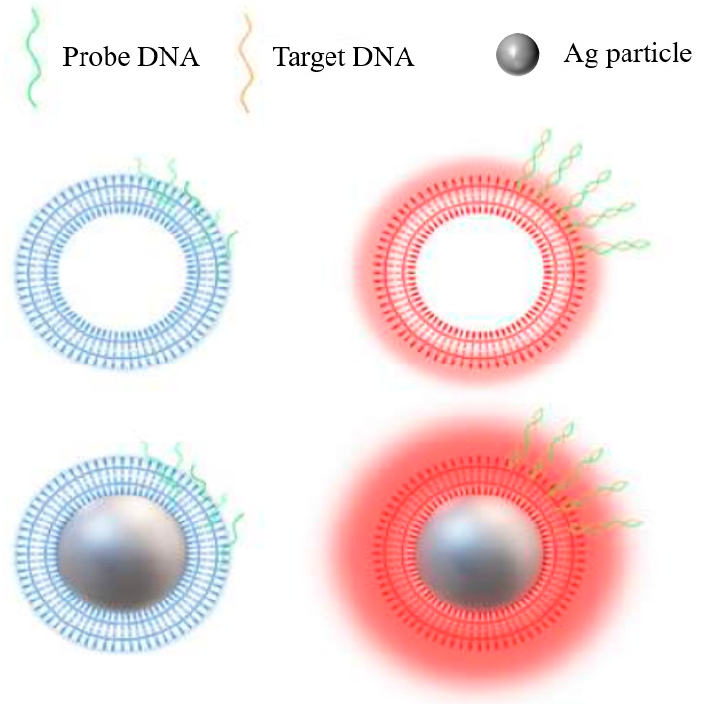
Figure 41. Schematic drawing of the DNA hybridization process [158].